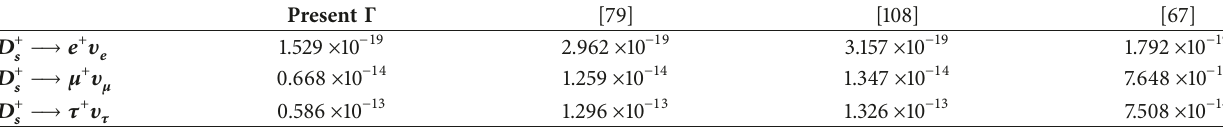
Table 11: Leptonic decay width of 𝐷 + 𝑠 meson in